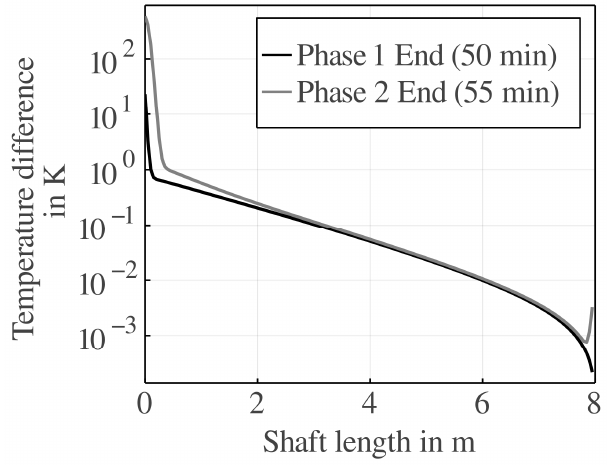
Figure 13. Comparison of resulting temperature differences radiation modeling in the bulk vs. no radiation modeling in the bulk at the ends of phase 1 and 2.